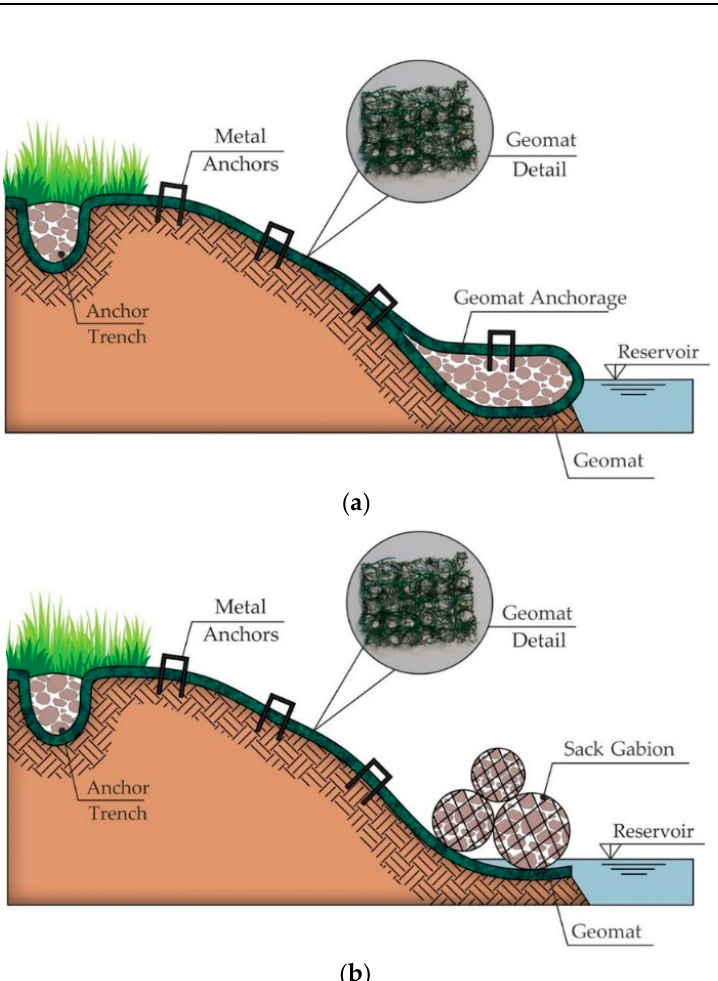
Figure 4. Schematic configuration profile of erosion control techniques: ( a ) geomat and ( b ) geomat and sack gabion.